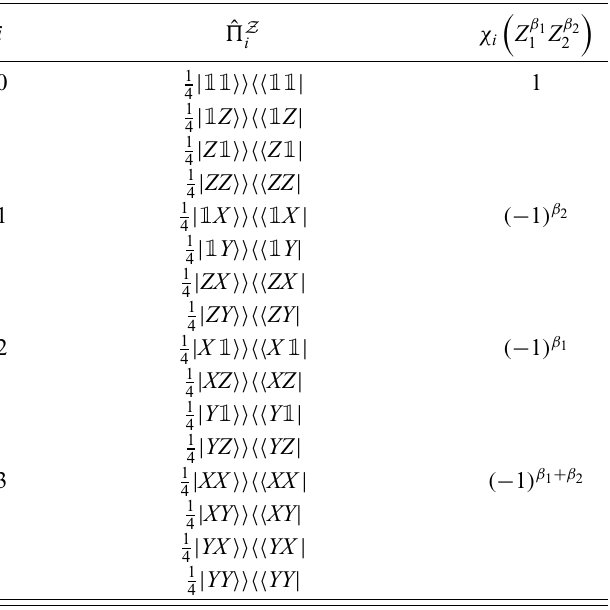
TABLE III. The irreps, projectors, and characters of the Liou- ville representation of P 1 .